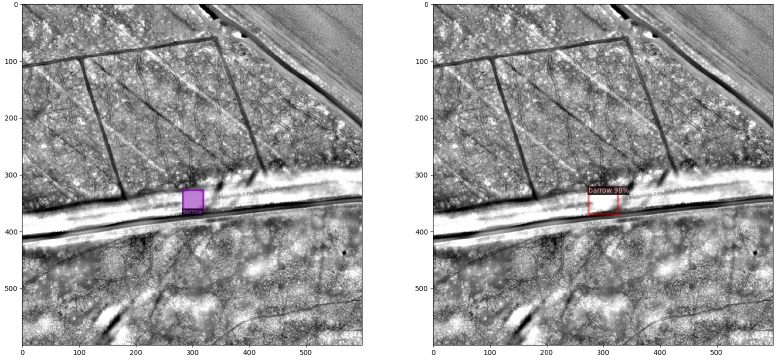
Figure 11. A comparison between a barrow ground truth ( left ) and the prediction ( right ) obtained with the X_101_32x8d_FPN_3x model, showing a wrongly approximated bounding